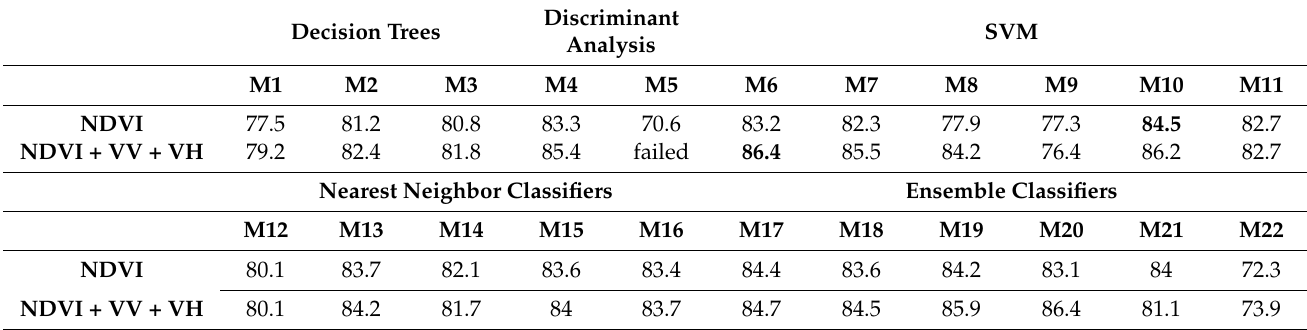
Table 3. Overall accuracy (OA) of the different classification methods with the available information. Decision